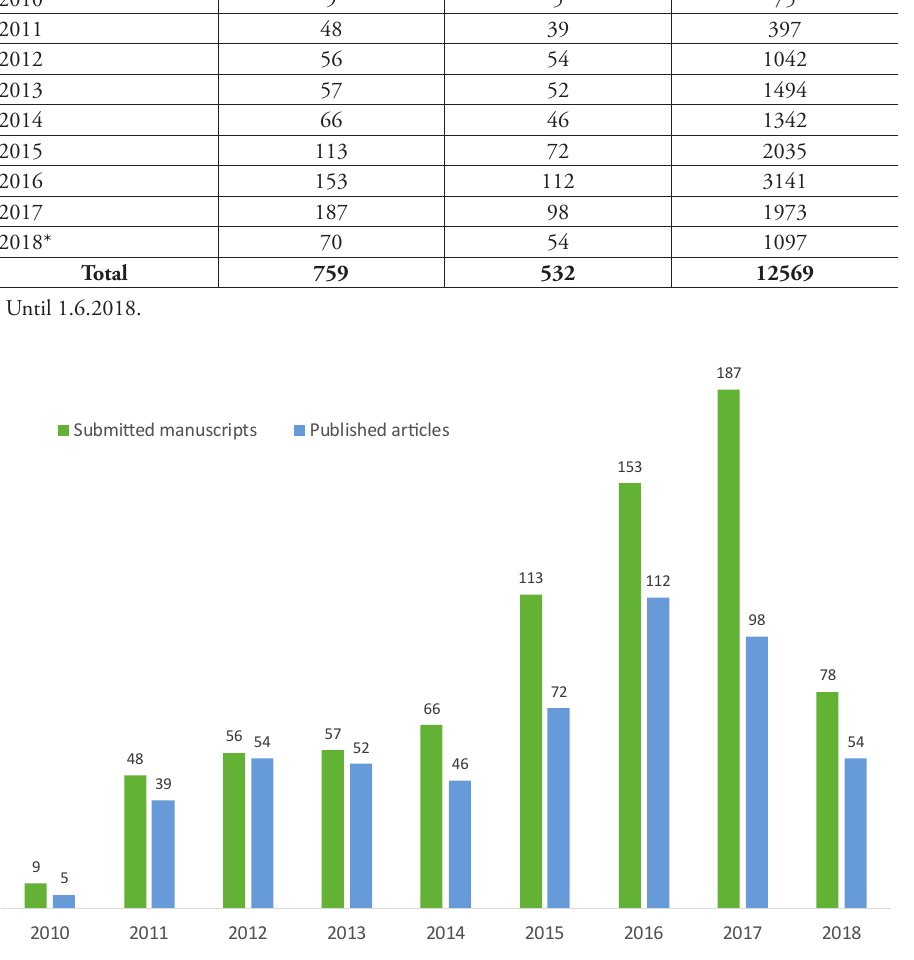
Figure 1. Growth of submitted manuscripts and published articles in PhytoKeys from 2010 to 2018 (until